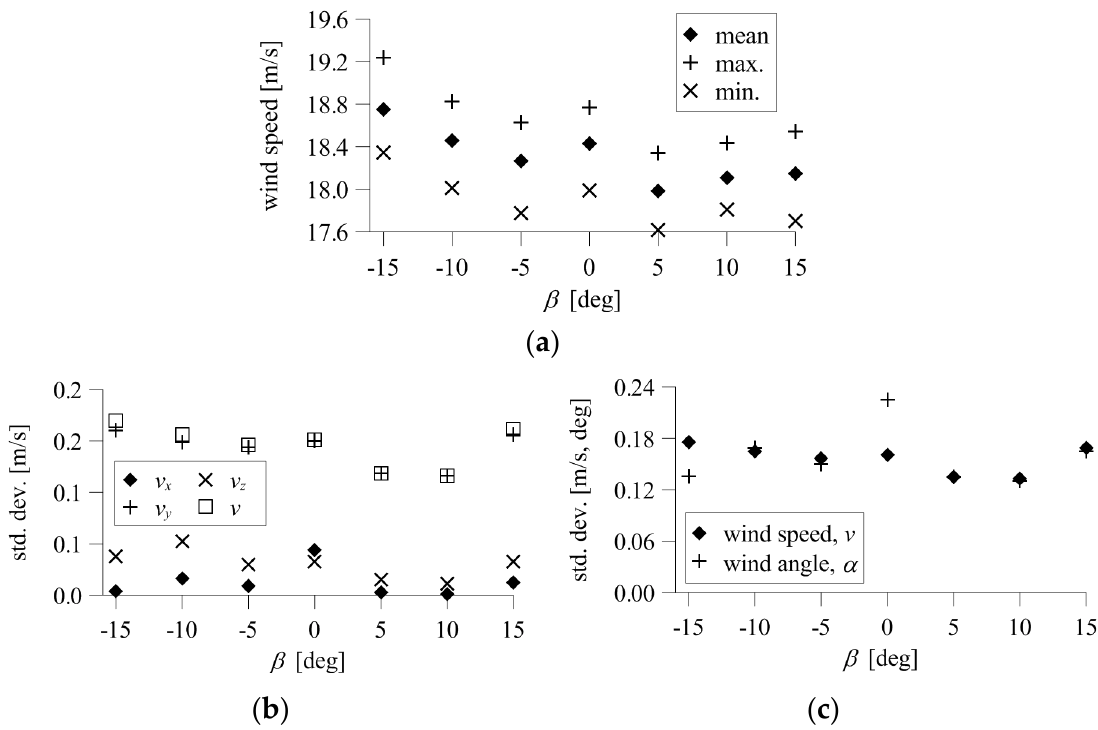
Figure 14. Results for the 3D anemometer: ( a ) mean and extreme resultant speed; ( b ) standard deviation of resultant speed, v , and components, v x , v y , v z ; ( c ) standard deviation of resultant speed and angle.